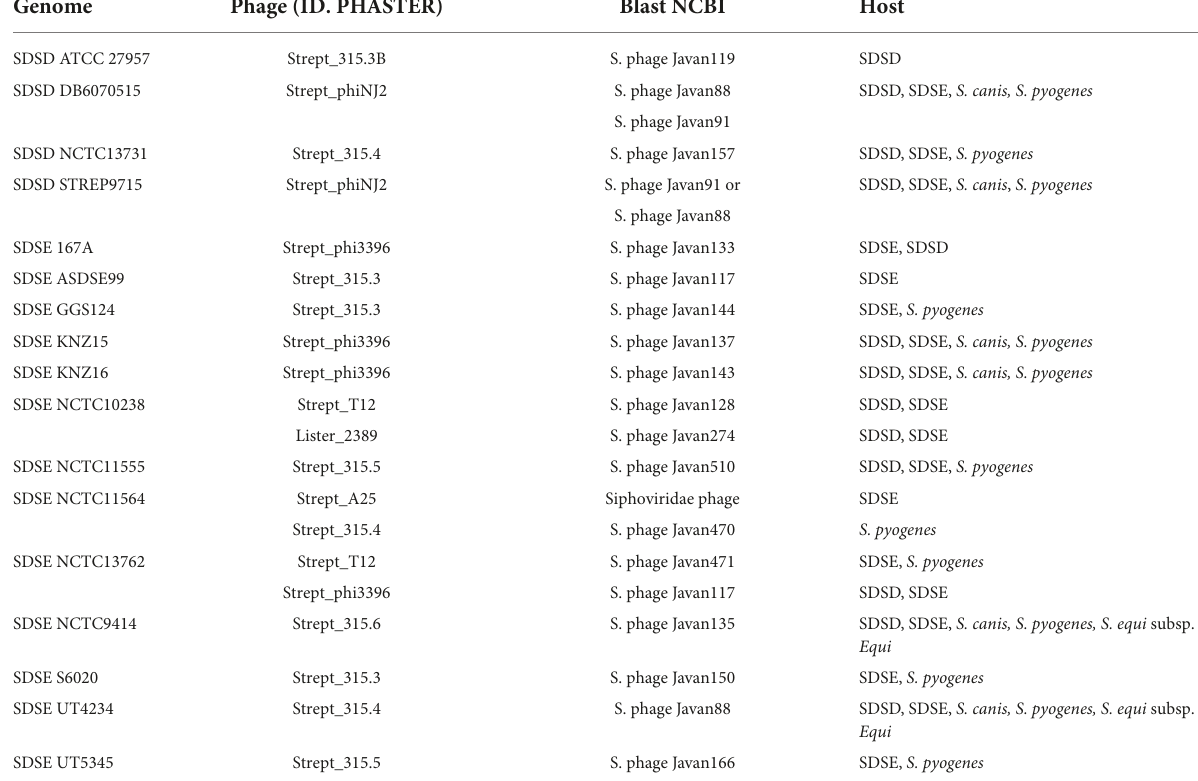
TABLE 4 Prophage genome identification using BLASTn at NCBI.